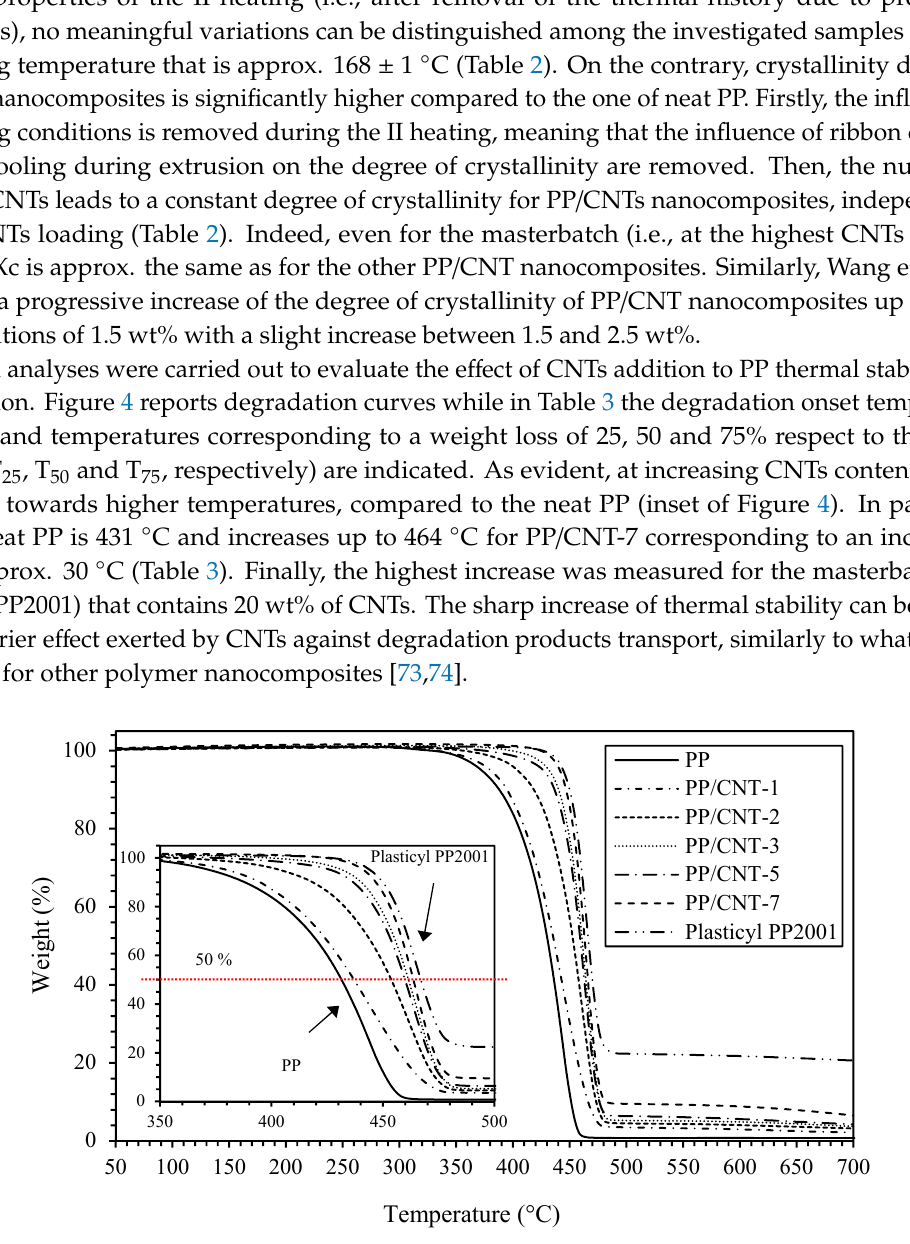
Figure 4. Weight loss of PP and PP/CNT nanocomposites (detail in the range 350 ‐ 500 °C in the inset). Table 3. Degradation onset temperature (T ONSET ) and temperatures corresponding to a weight loss of 25, 50 and 75% respect to the initial